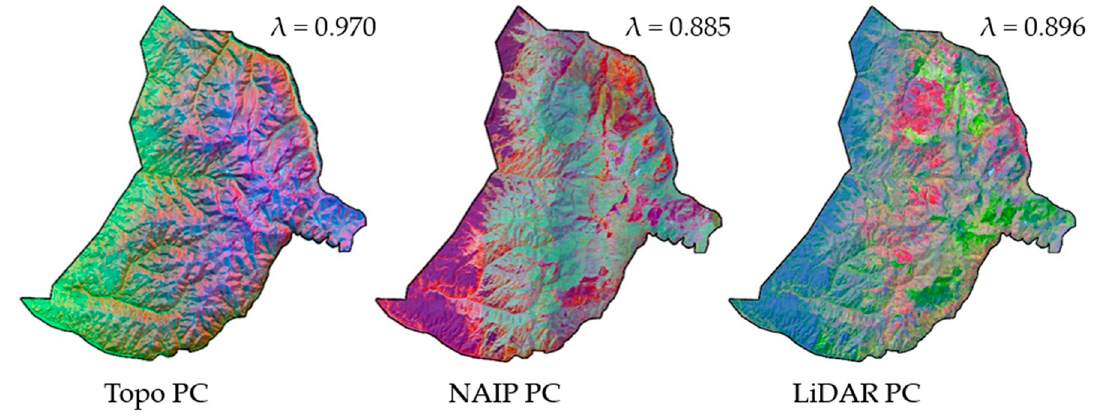
Figure 7. Illustration of TOPO, NAIP, and LiDAR principal component raster datasets. Note that only the first three components are displayed by the red-green-blue-color composite. The proportion of correlation explained ( λ ) by those components is display above each raster dataset.